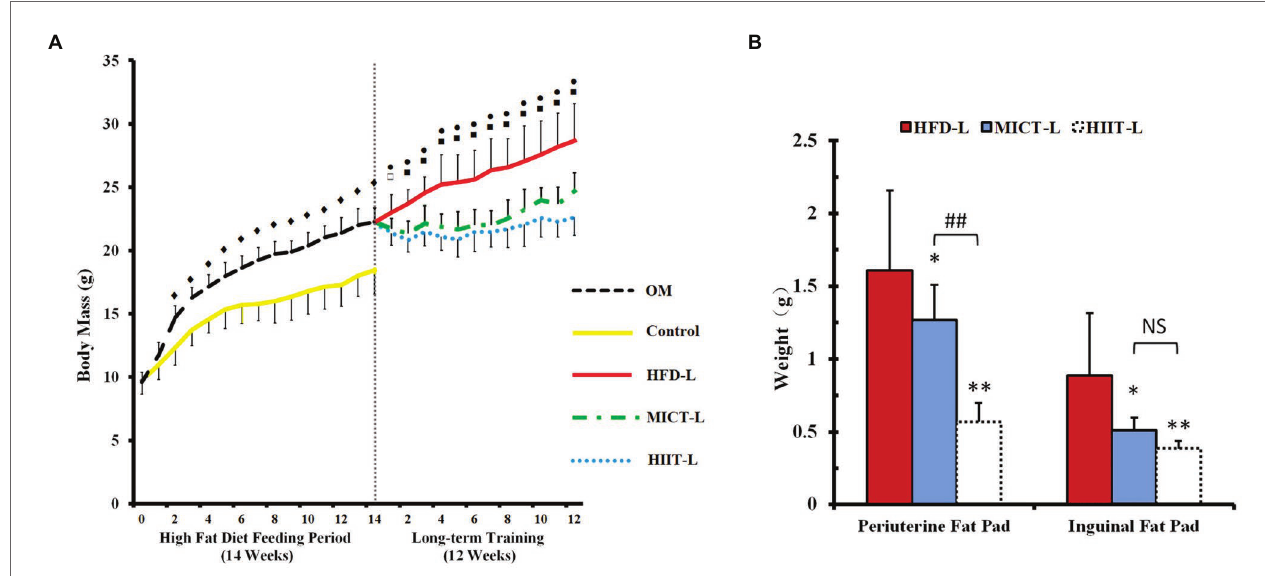
FIGURE 3 | Body mass (A) and fat pads weights (B) of long-term exercise groups. Periuterine fat pad represents visceral fat, while inguinal pad represents subcutaneous fat. Data are mean ± SD. (A) ♦ p < 0.01 OM vs. C, ⚫ p < 0.01 HIIT-L vs. HFD-L, ▫ p < 0.05 MICT-L vs. HFD-L, ▪ p < 0.01 MICT-L vs. HFD-L, and no significant difference of body mass between MICT-L and HIIT-L. (B) * p < 0.05 vs. HFD-L, ** p < 0.01 vs. HFD-L, ## p < 0.01 MICT-L vs. HIIT-L, and NS, no significant